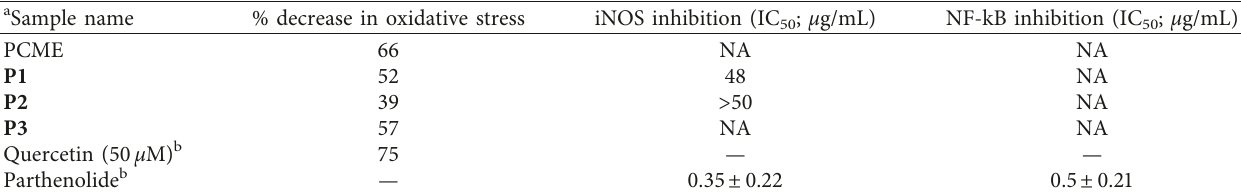
Table 2: Anti-inflammatory activity of PCME and P1 , P2 , and P3 .